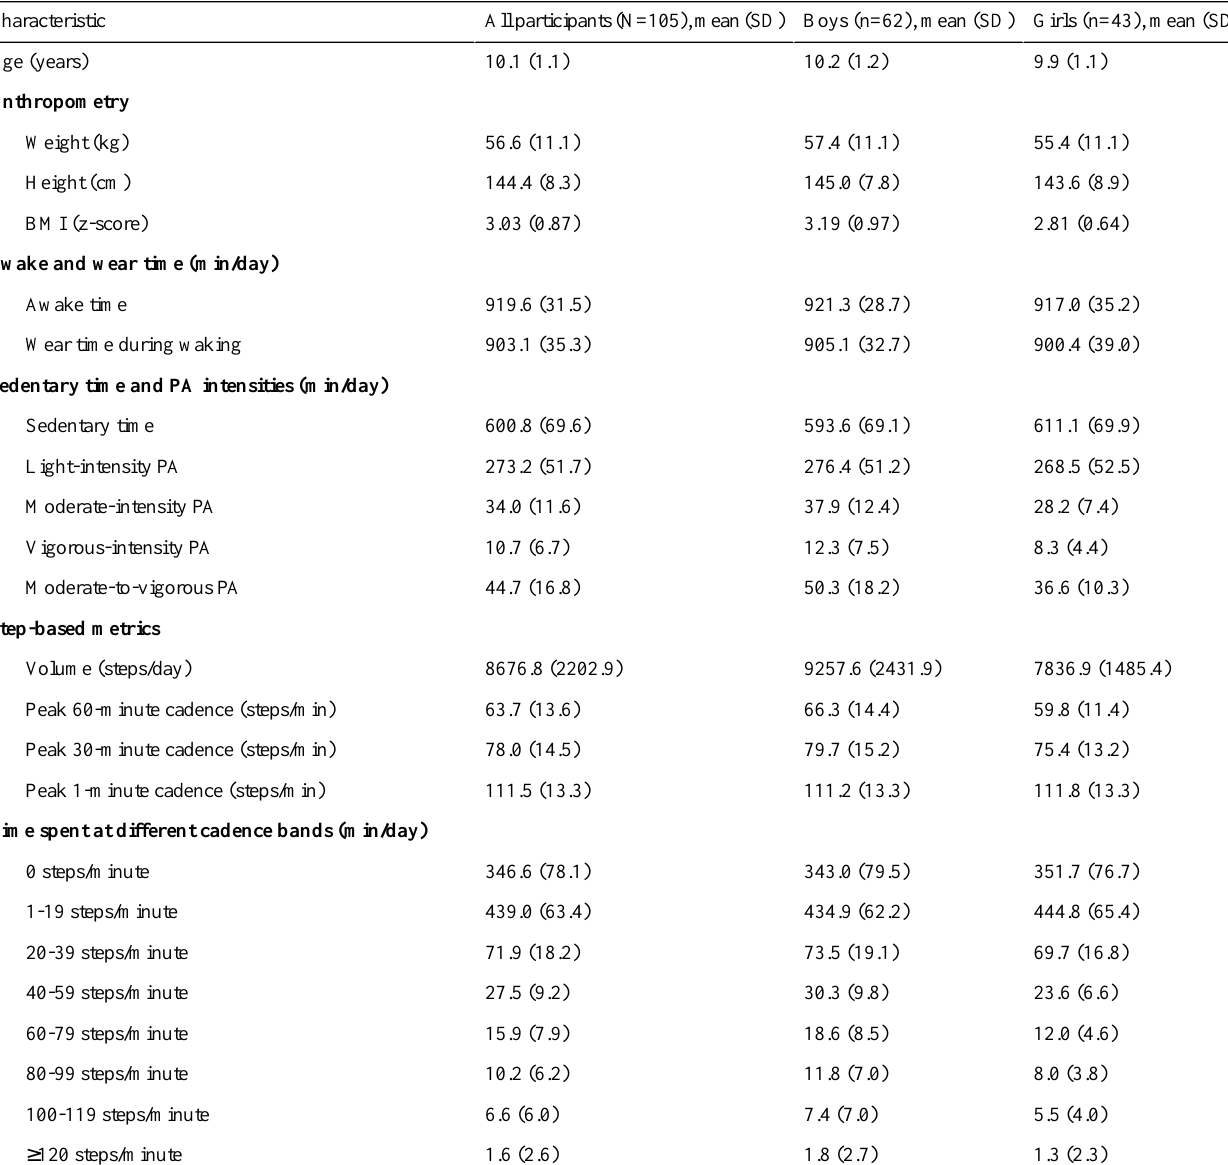
Table 1. Anthropometry, sedentary time, time-based physical activity (PA) metrics, and step-based metrics of overweight and obese